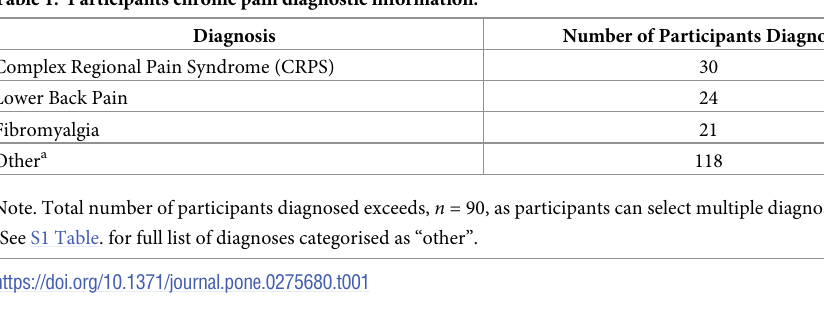
Table 1. Participants chronic pain diagnostic information.